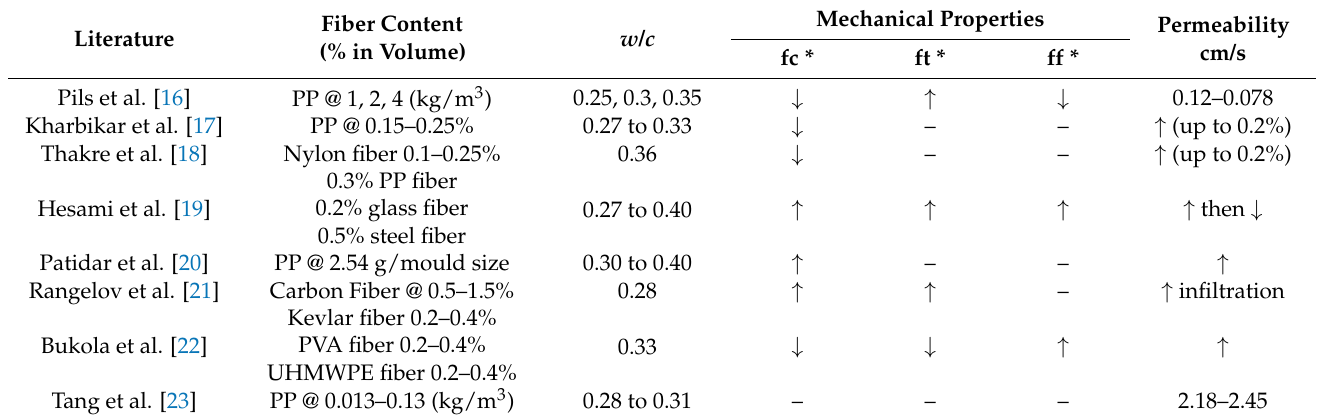
Table 1. Summary of research on fiber-reinforced pervious